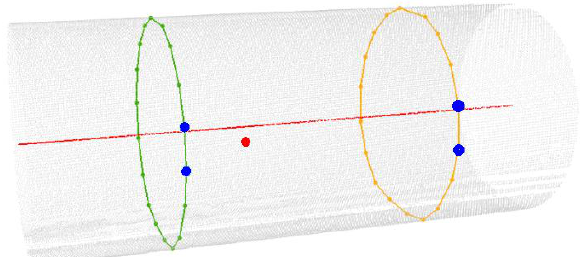
Figure 10. The two closest points in the cross-section and its homologous in the other section (4 blue points) for the point under analysis (red point).